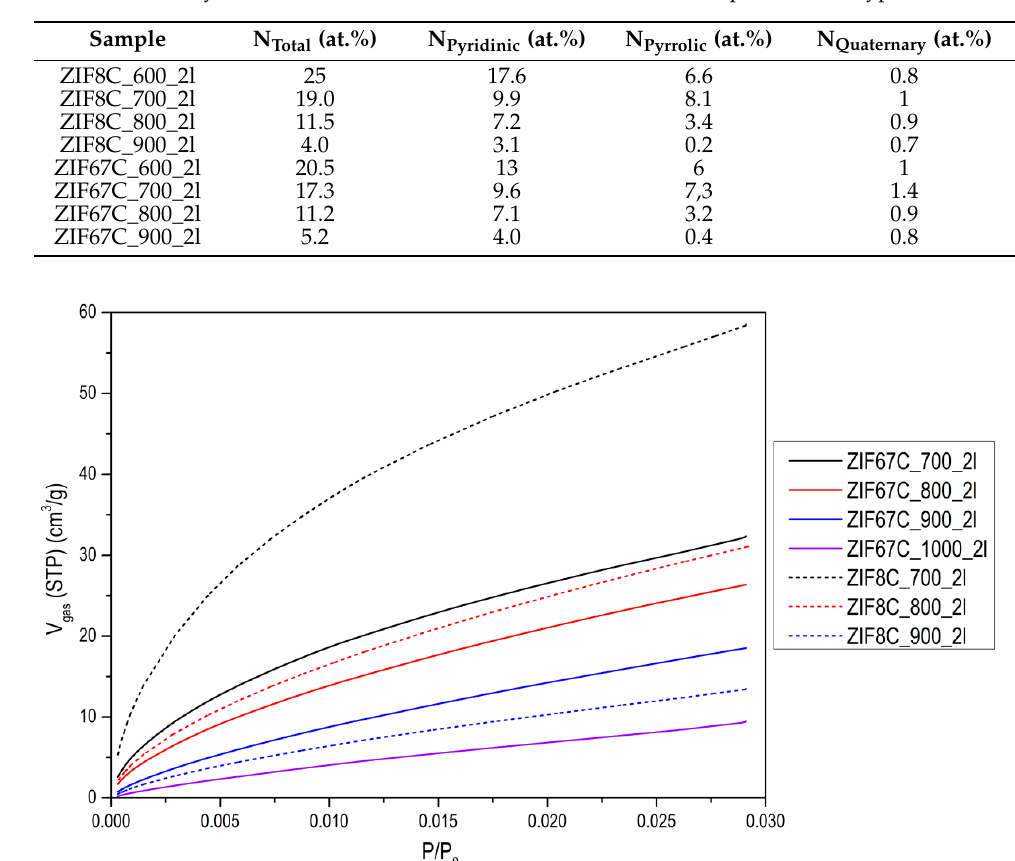
Figure 5. CO 2 adsorption isotherms at 0 °C of some of the activated carbons.